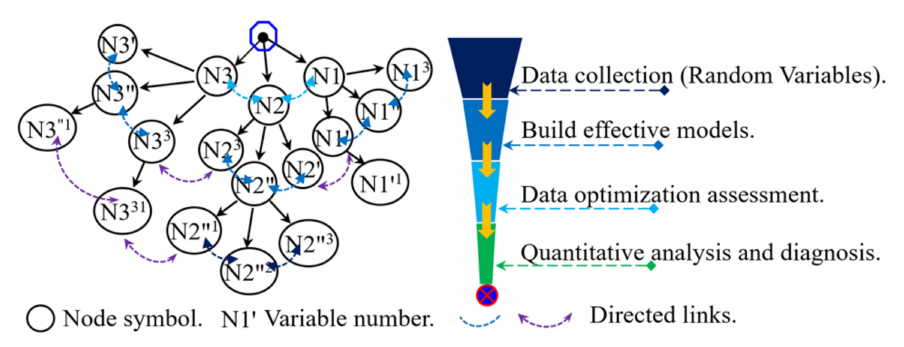
Figure 2. Schematic diagram of BN principle.